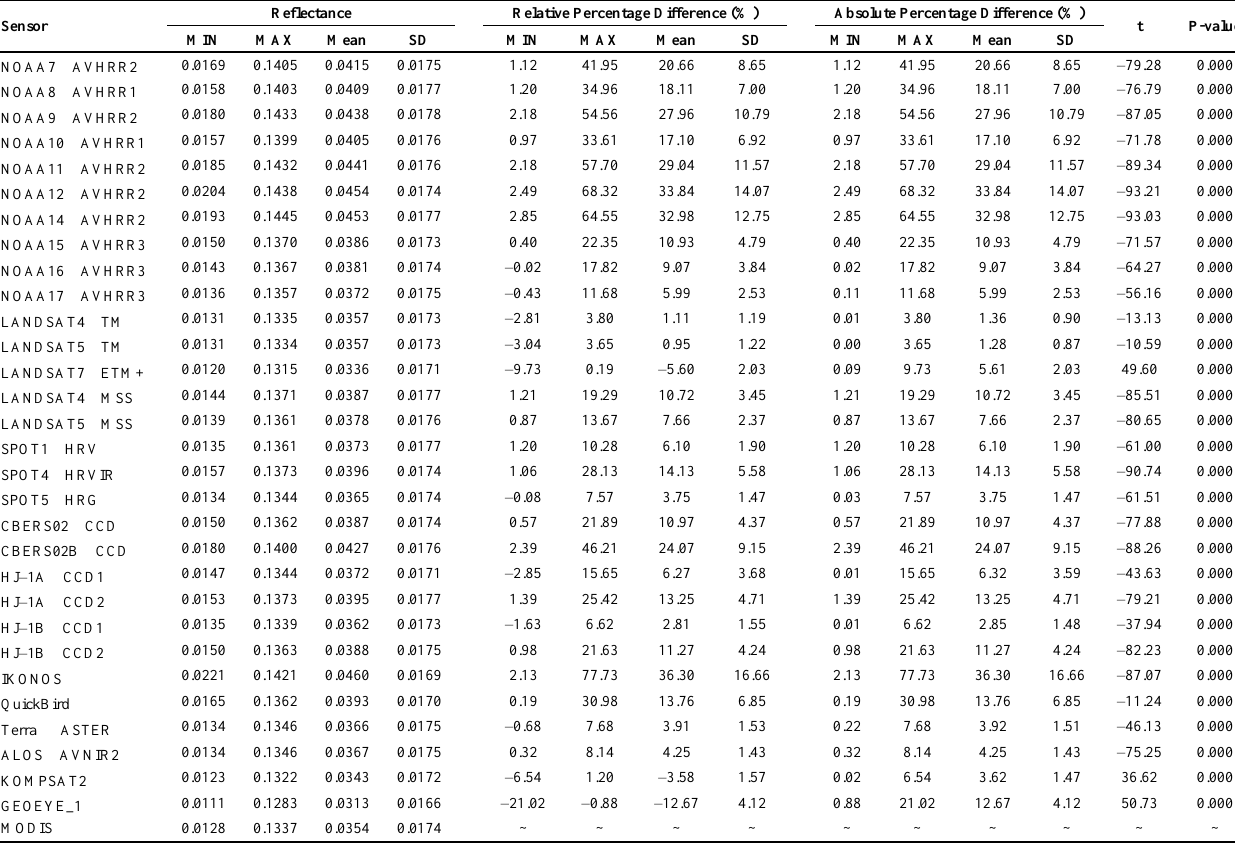
Table 2. Statistical description of the simulated red reflectance, the relative percentage difference (RPD) and the absolute percentage difference (APD) with respect to Terra MODIS. N =